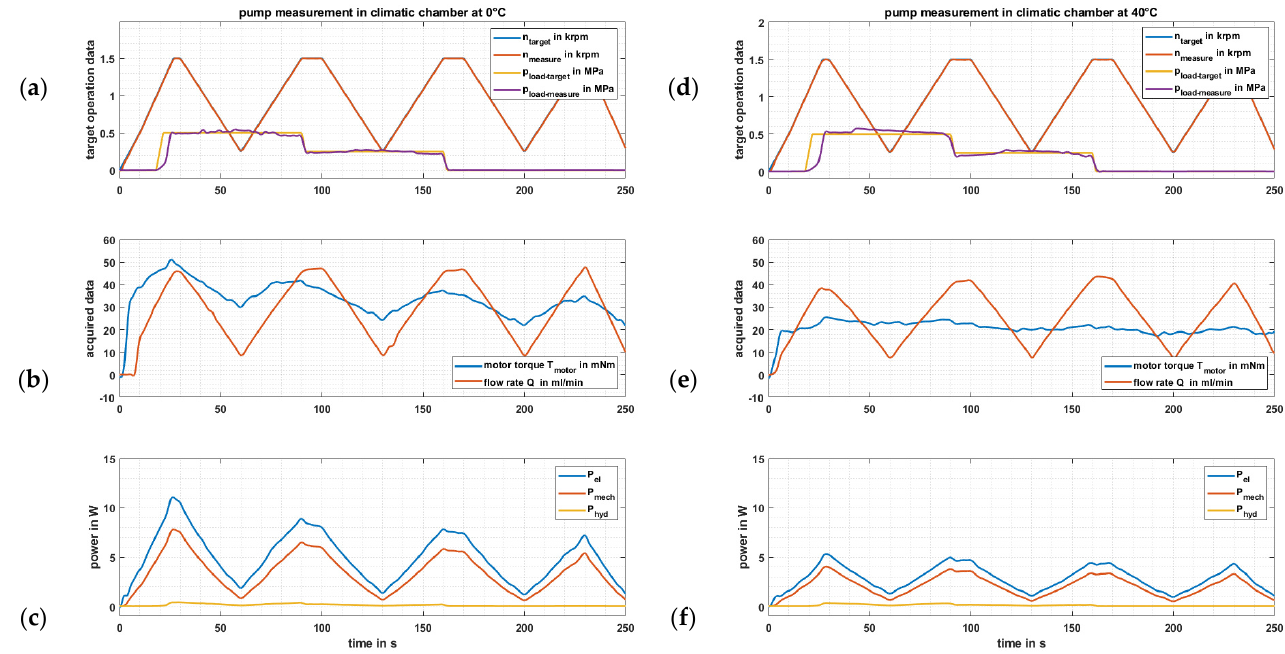
Figure 29. Results are structured as in Figure 28 but for different temperatures; ( a – c ) results of the test cycle at 0 ◦ ; ( d – f ) results of the test cycle at 40 ◦ C.